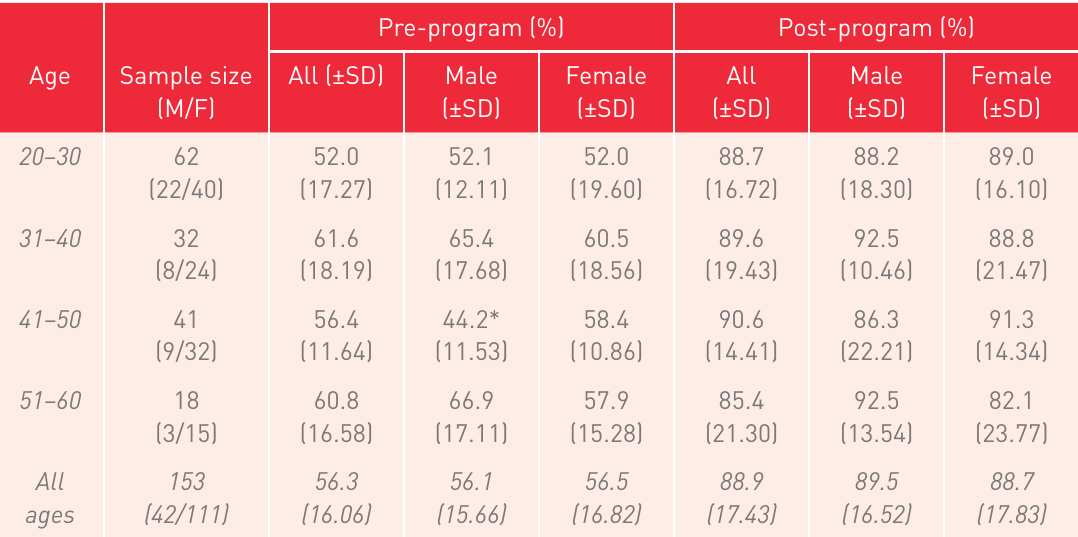
Overall pre-program and post-program mean scores (expressed as percentages) for those who took both tests (n=153), as well as the scores for males and females within each age range. All post-program test scores are significantly greater (P<0.01) than the pre-program